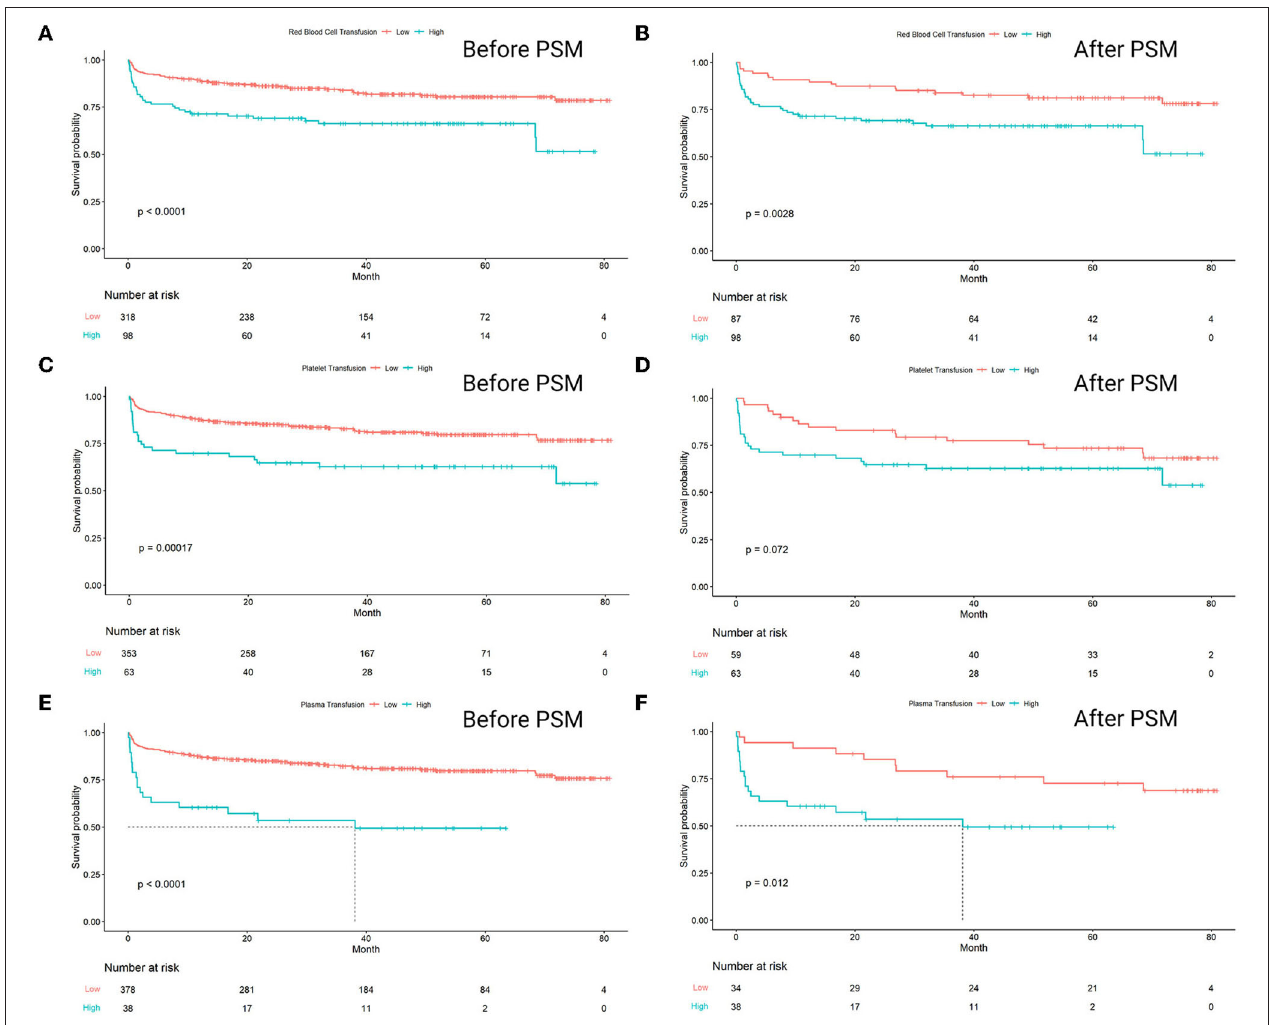
FIGURE 4 | Kaplan–Meier analysis estimates survival after heart transplantation with log-rank test, comparing the outcomes between high amount transfusion group and low amount transfusion group. The analysis results were separately shown below, in which the study population was divided into two groups based on the transfusion amount of (A) Red blood cell (beforematching), p < 0.0001; (B) red blood cell (aftermatching), p = 0.0028; (C) platelet (beforematching), p = 0.00017; (D) platelet (aftermatching), p = 0.072; (E) plasma (beforematching), p < 0.0001; (F) plasma (aftermatching), p =